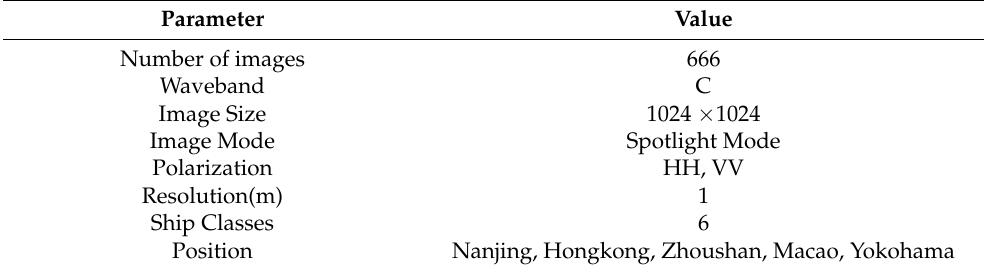
Table 1. The basic parameters of SRSDD.